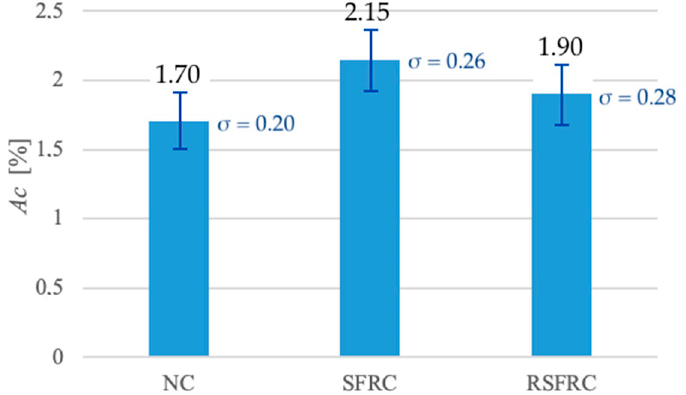
Figure 14. Comparison of the air content ( Ac ) for mixtures without fibres (NC) and with steel fibres (SFRC and RSFRC).